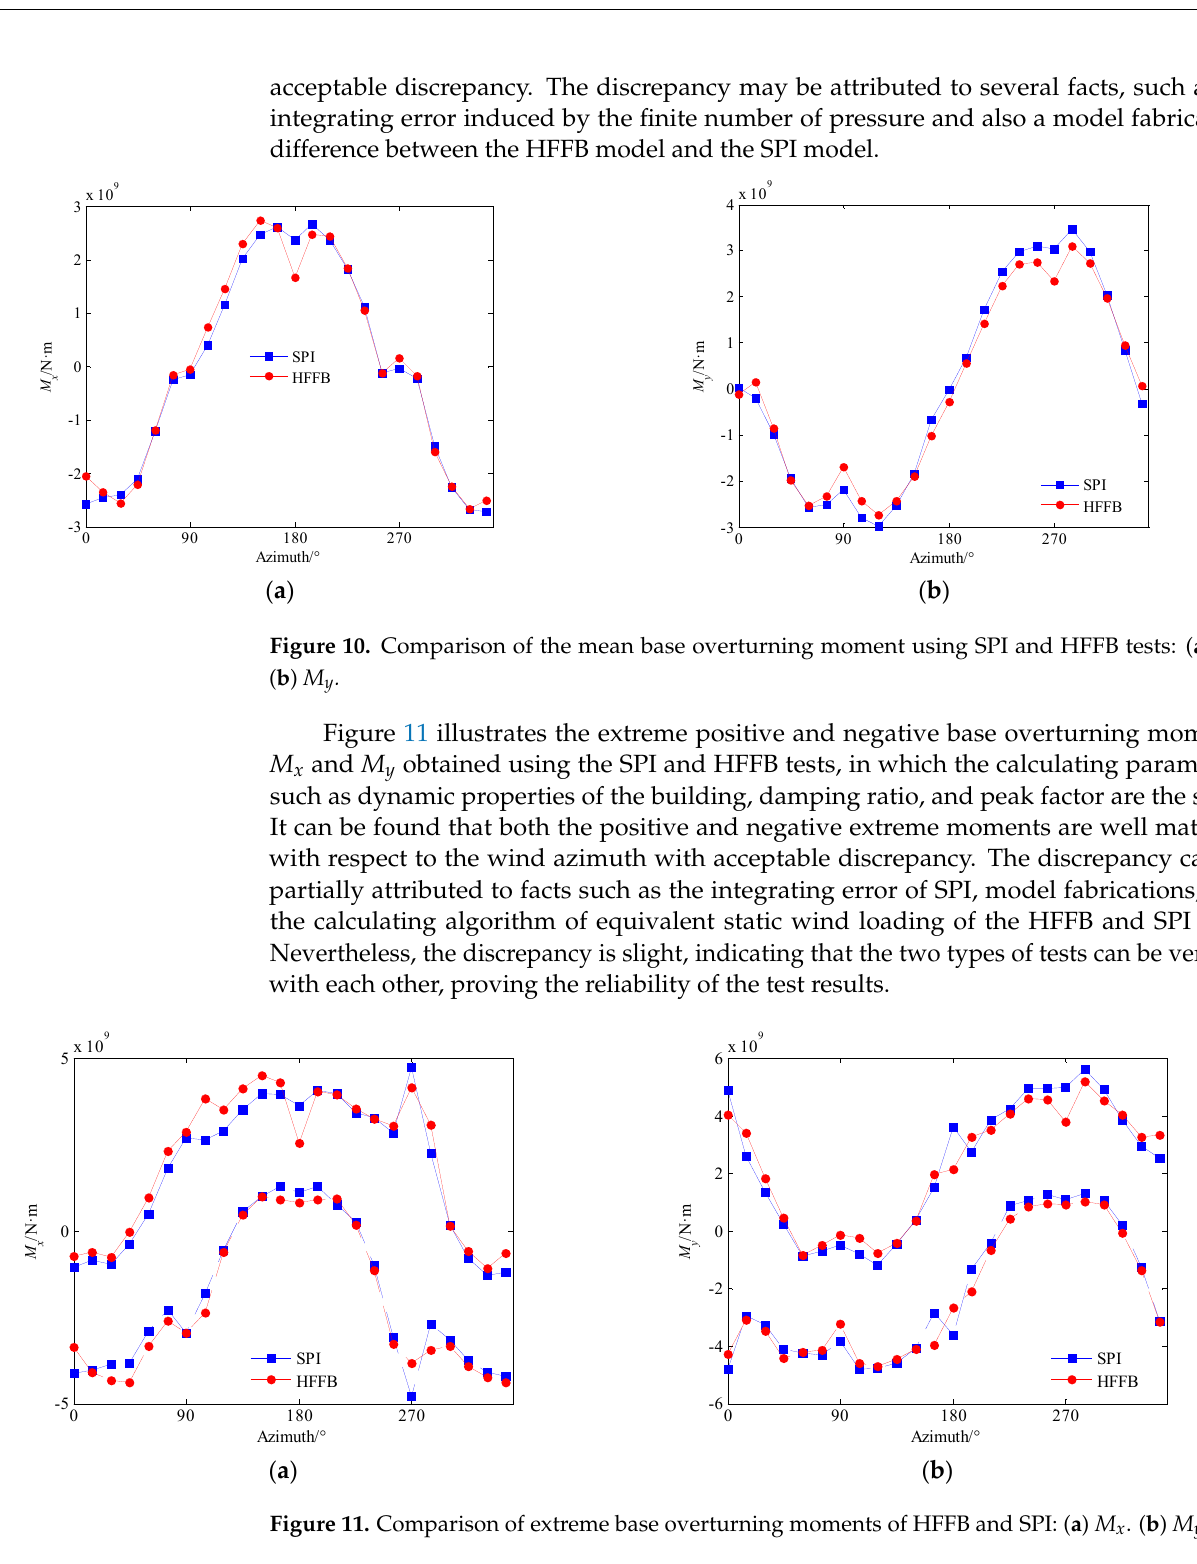
( b ) Figure 9. ( a ) Model and surroundings in the wind tunnel. ( b ) Pressure test model. Table 4. Layout of pressure taps. Height